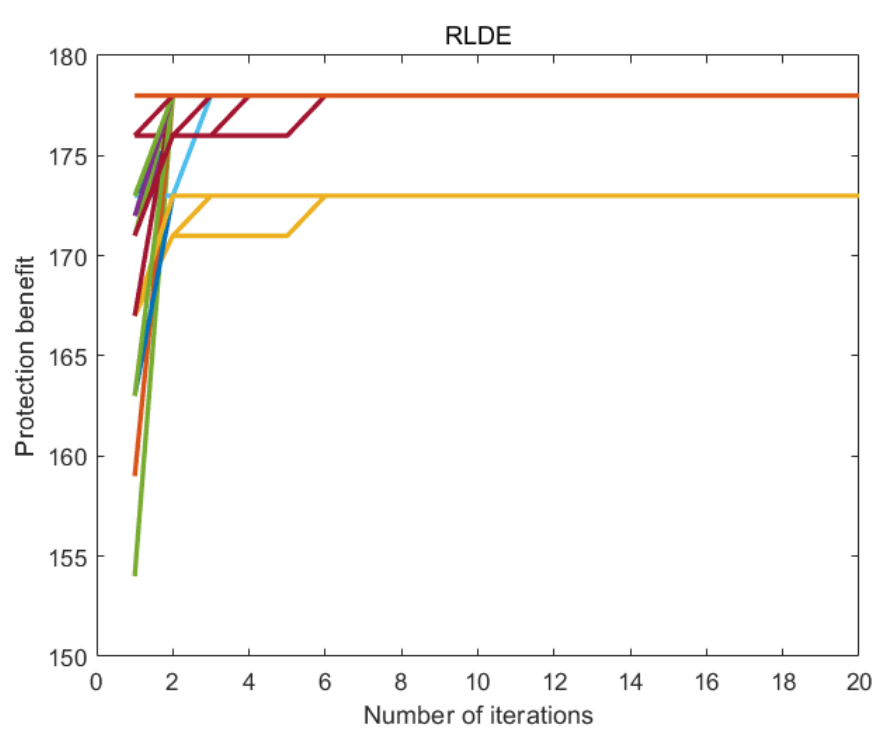
Figure 13. Population size is 100, and the RLDE algorithm is run 100 times.